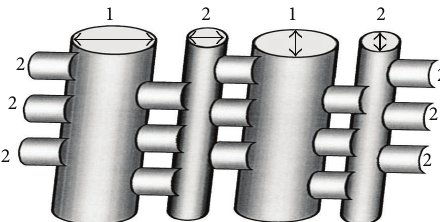
Figure 1: Channel structure of mordenite type zeolite [5].